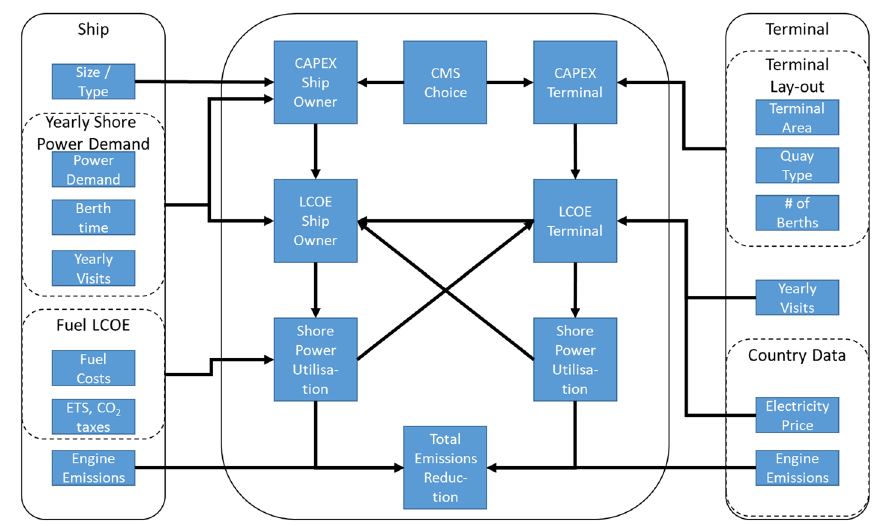
Fig. 3 Cold ironing integrated ship-terminal model overview. Source :